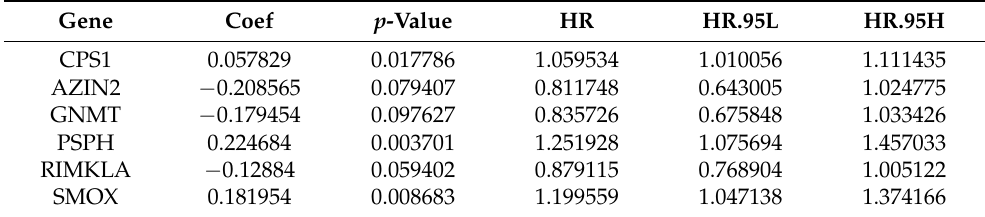
HR: hazard ratio; L: low; H: